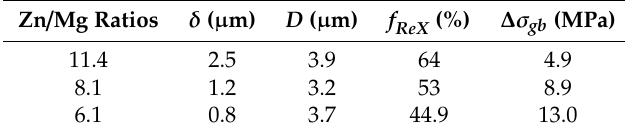
Table 2. Calculating strength from grain boundaries strengthening.